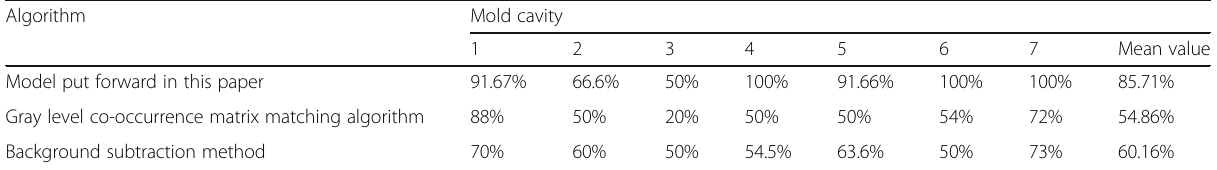
Table 1 Detection precision of the residues in the mode cavity